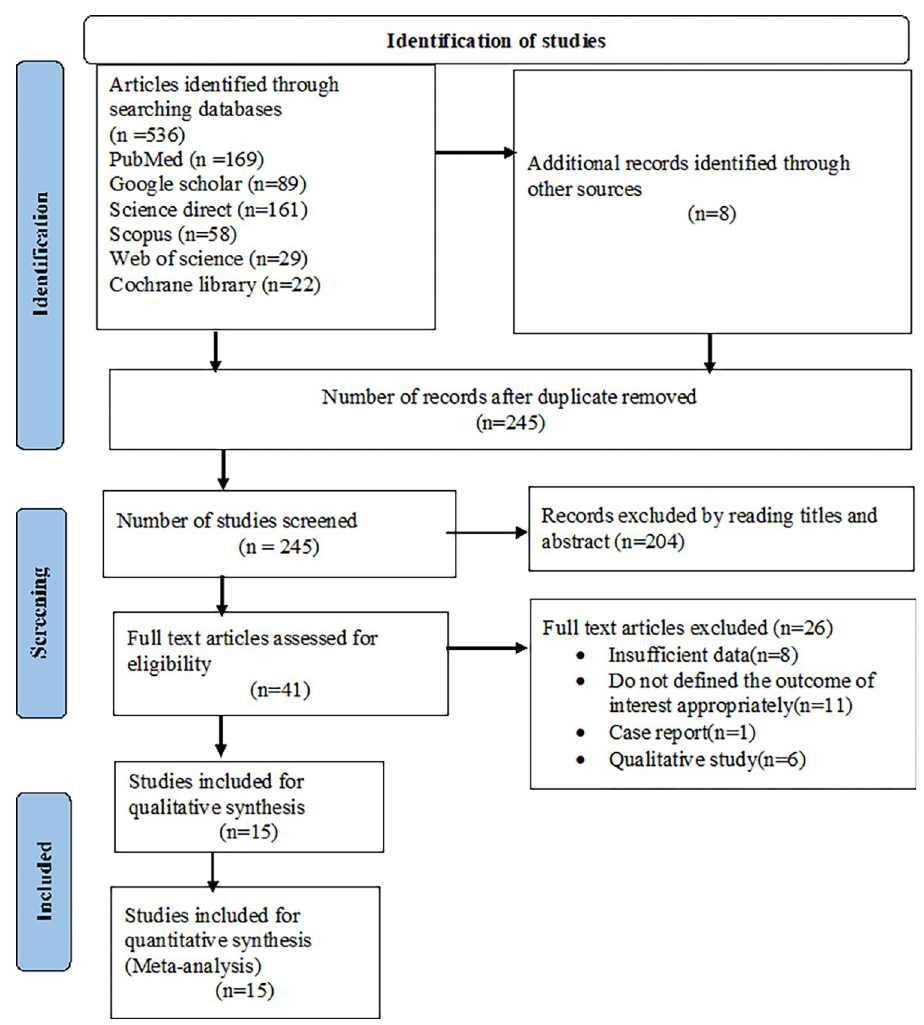
Fig 1. PRISMA flow diagram describing the selection of studies for systematic review and meta-analysis.